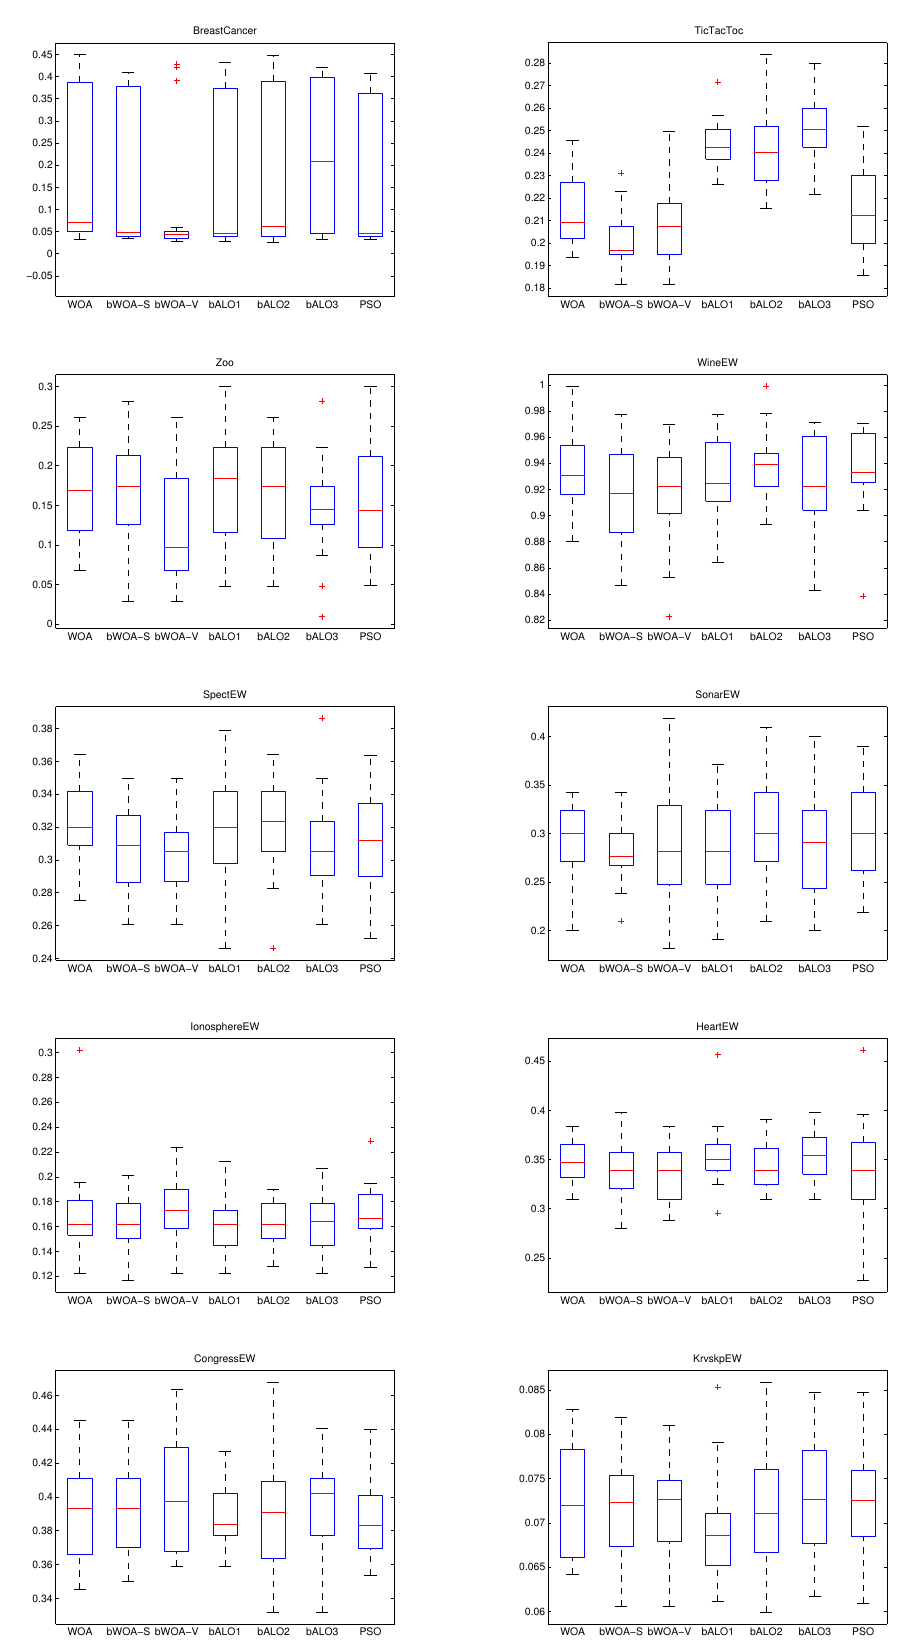
Figure 8. Large initialization boxplot for the compared algorithms on the different